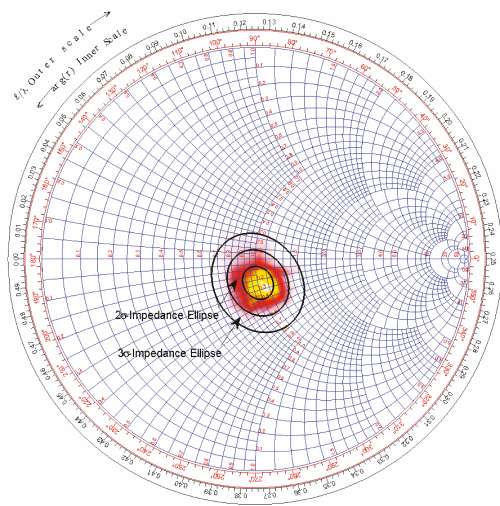
Figure 7: 1 σ , 2 σ , and 3 σ ellipses for the Cantor antenna in UTRA/FDD LTE B3